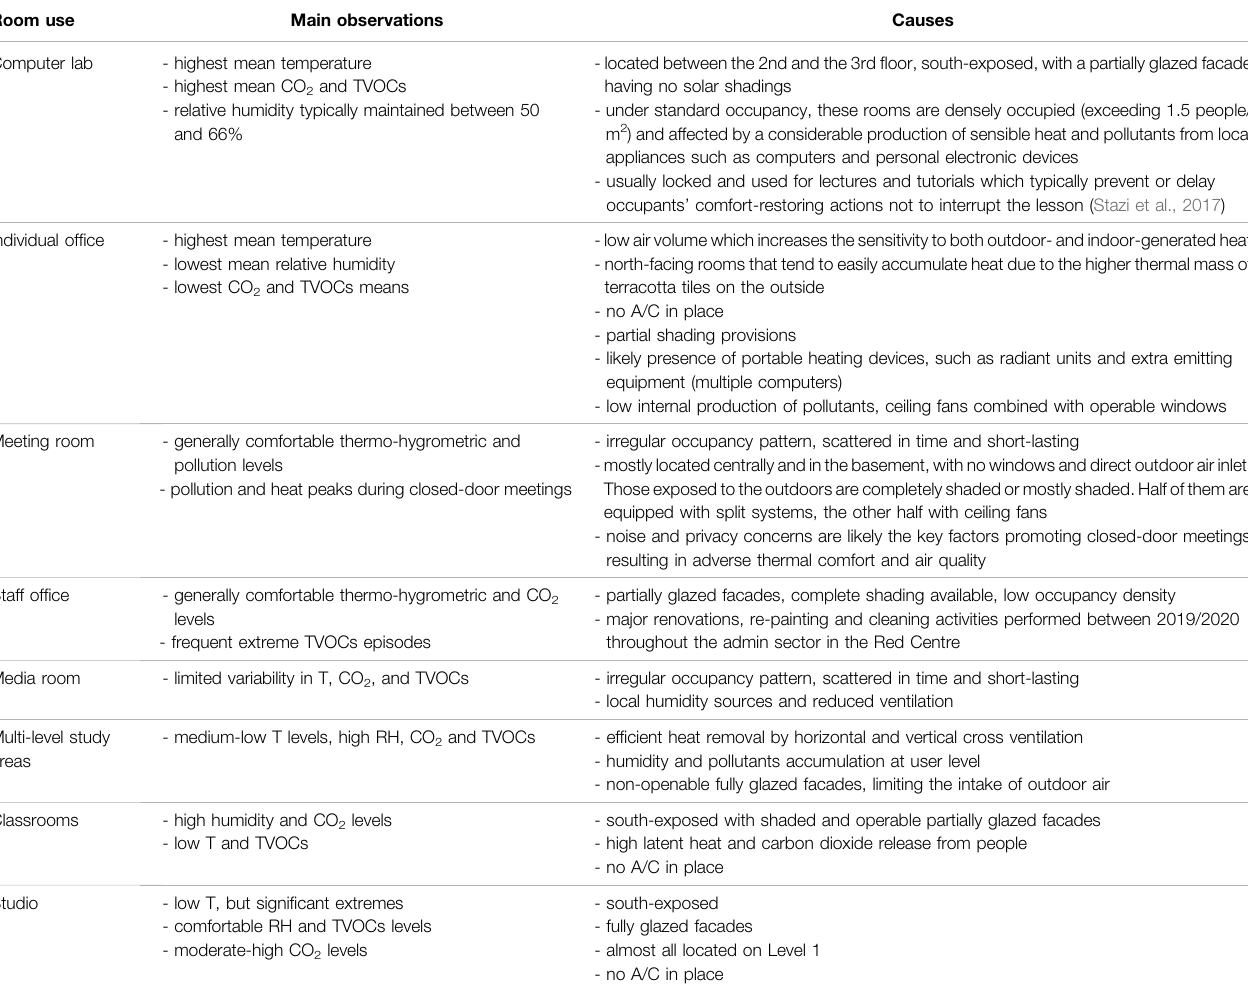
TABLE 3 | Typical IEQ pattern per room use under standard